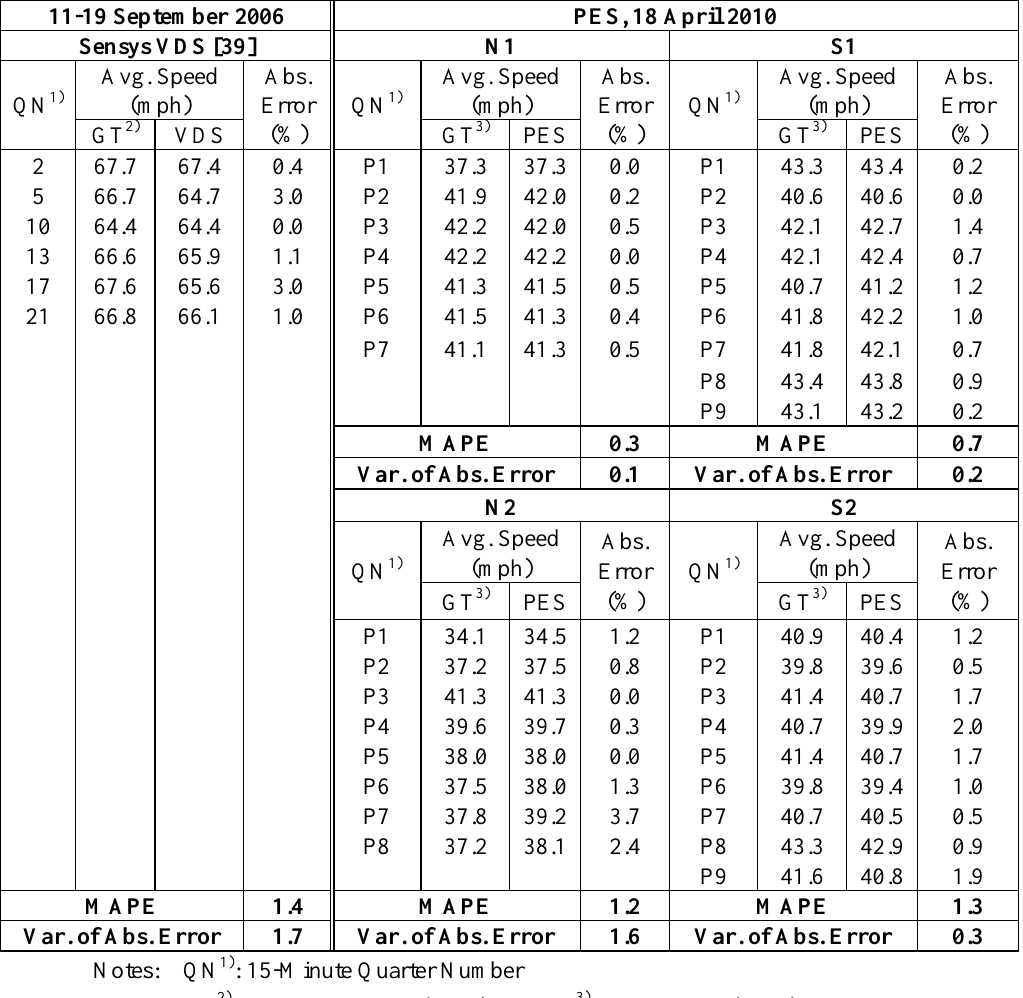
Table 8. Speed accuracy comparison between PES and Sensys VDS